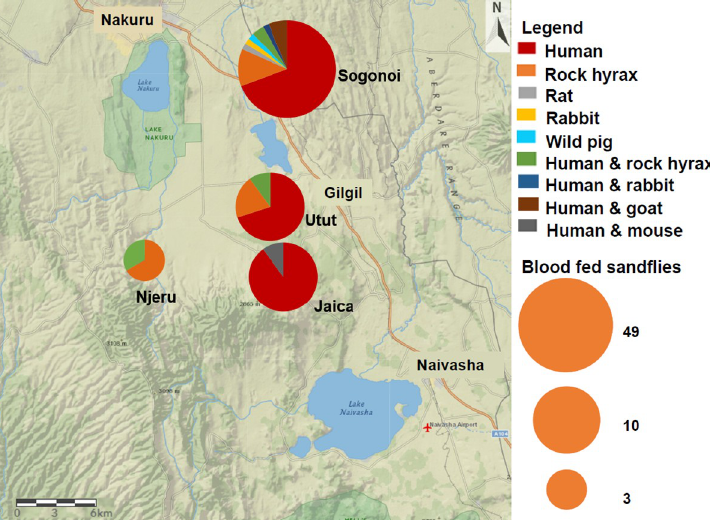
Fig 6. Map of Gilgil showing the proportions of bloodmeal sources per trapping site. The map was designed using ArcGIS Online